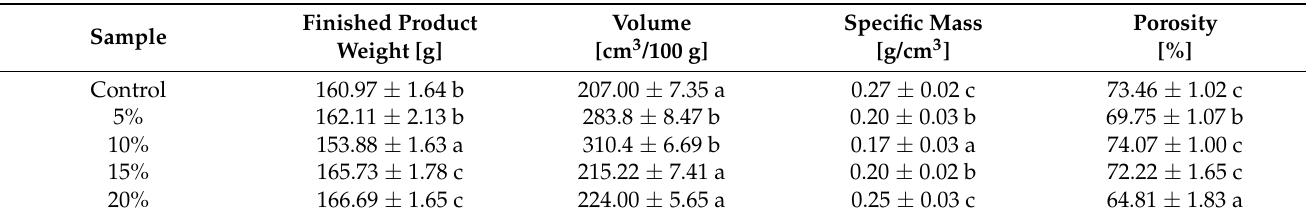
Table 2. Weight, volume, specific weight and porosity of gluten-free bread with the addition of chestnut flour in the amount of 0, 5, 10, 15 and